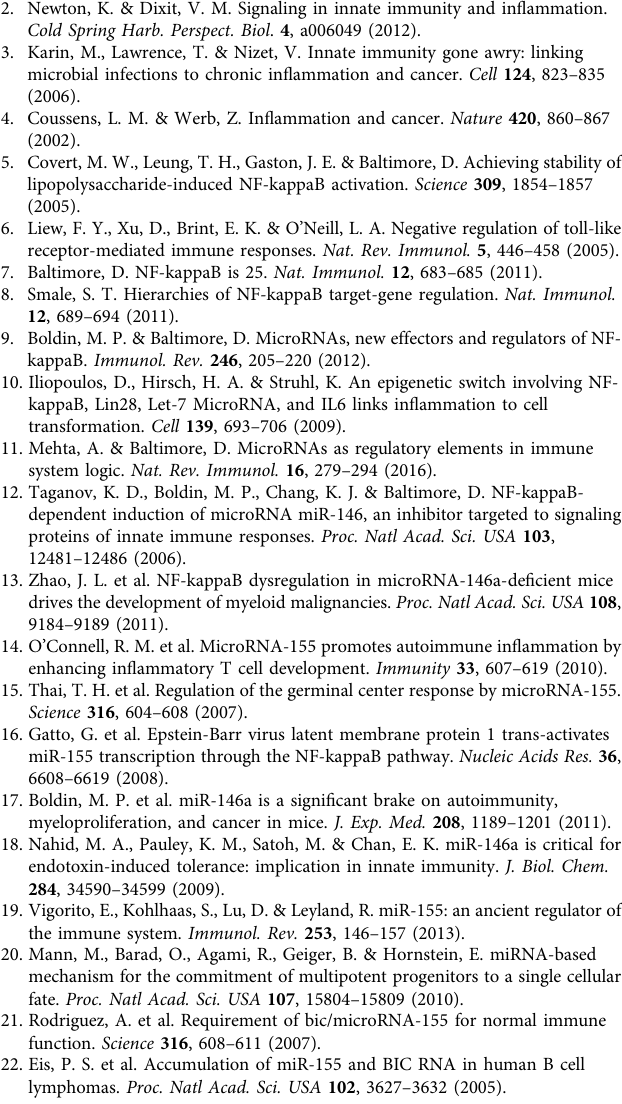
Table 2. The quanti fi cation of miR-146a and miR-155 targets following com- plementary DNA (cDNA) synthesis was done using qScript cDNA SuperMix (Quanta cat: 95048-100) and detection with PerfeCTa qPCR Fastmix with ROX (Quanta cat: 95119-012) as per manufacturer ’ s instructions. Sample preparation for RNA sequencing . BMMs from WT, miR-155 − / − , miR- 146a − / − and DKO were cultured and treated as described above. Cells were lysed using an RNeasy kit (cat no: 74104 Qiagen) with DNAseI digestion (cat no: 79254 Qiagen) as per manufacturer ’ s protocol. RNA-seq libraries were prepared from polyA + -selected RNA using the TruSeq RNA Sample Preparation kit (Illumina RS- 122-2001) at the Millard and Muriel Jacobs Genetics and Genomics Laboratory